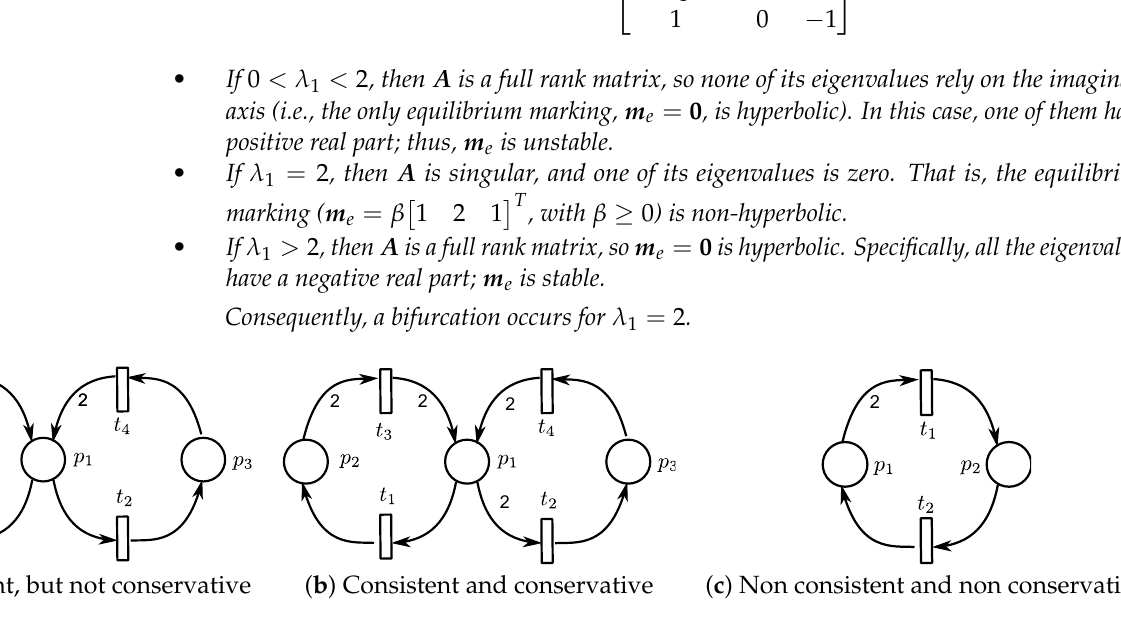
Figure 7. Three strongly connected JF Petri nets: ( a ) its TCPN system exhibits bifurcations; ( b , c ): their TCPN systems do not exhibit